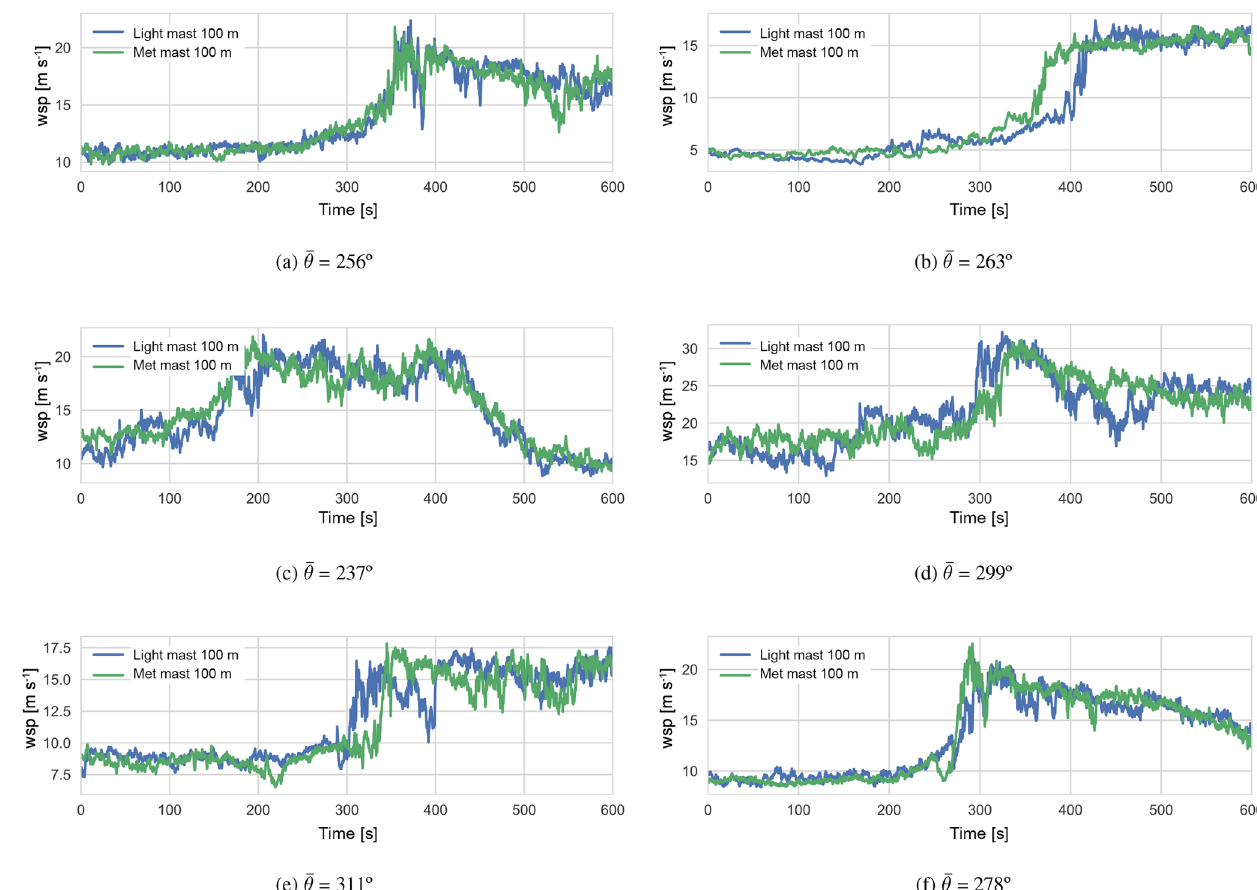
Figure 3. Comparison of horizontal wind speed measurements at the meteorological mast (green curve) and the light mast (blue curve). The measurement height is 100m at both masts, which are separated by ≈ 400m. The 10min averaged wind direction θ is from the light